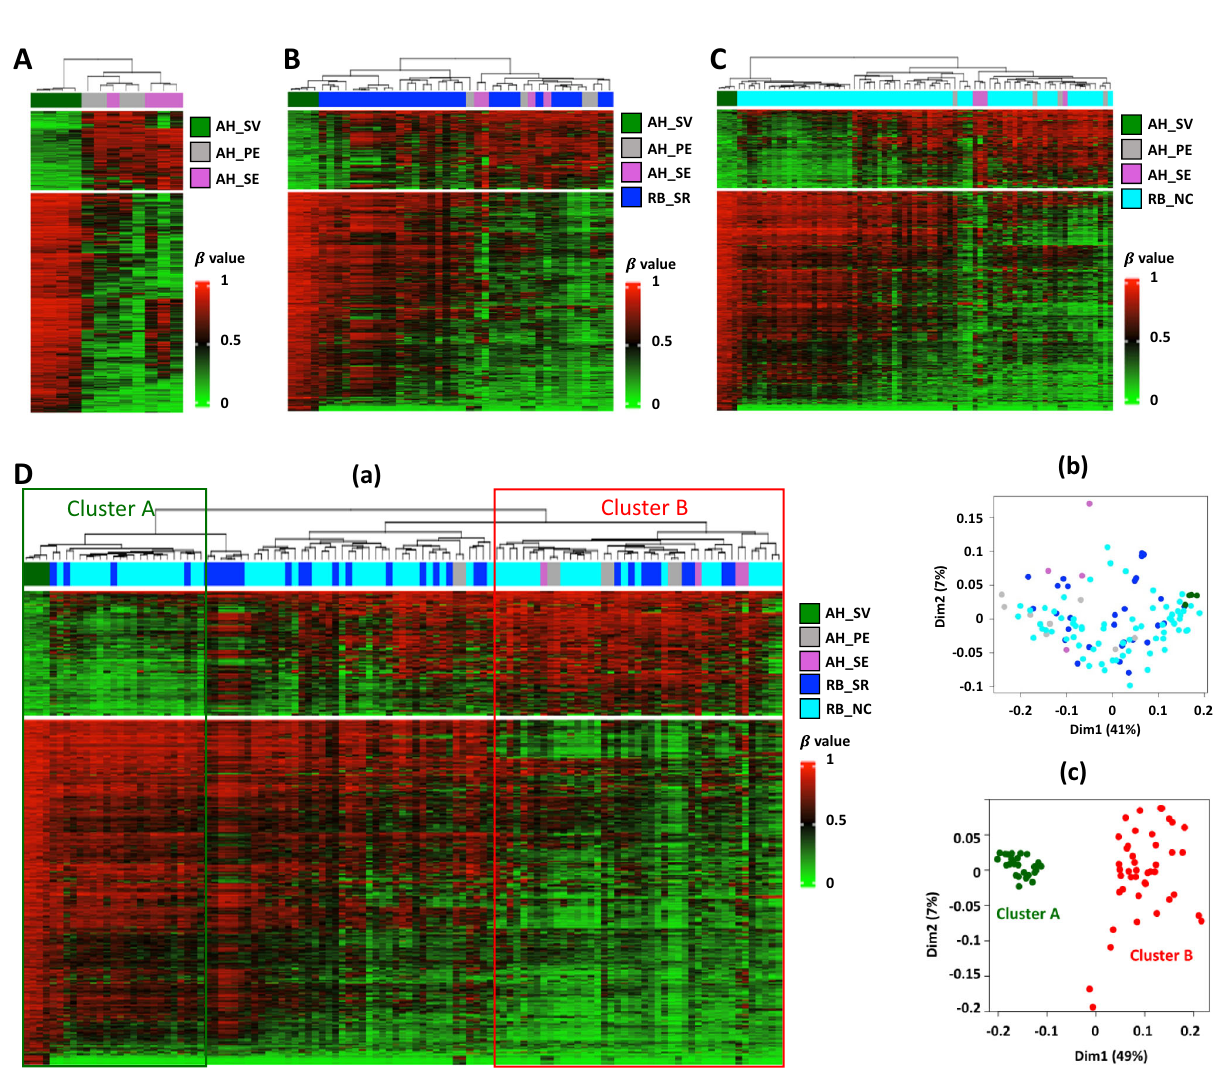
Fig. 5 | Identi fi cation of speci fi c DNA methylation clusters from AH cfDNAs. A Unsupervisedhierarchicalclusteringofthe1092differentiallymethylatedprobes betweensalvaged(AH_SV,darkgreenontop, n =4)andenucleated(AH_PE,primary enucleated ( n =4) and AH_SE, secondary enucleated ( n =4), gray and magenta on top) samples (top panel). The bottom panel showed the salvaged and enucleated samplescanbe wellseparated bytheselectedprobes. B Unsupervisedhierarchical clusteringheatmapofCHLAAHsamples( n =12)andenucleatedRBtumors( n =30)